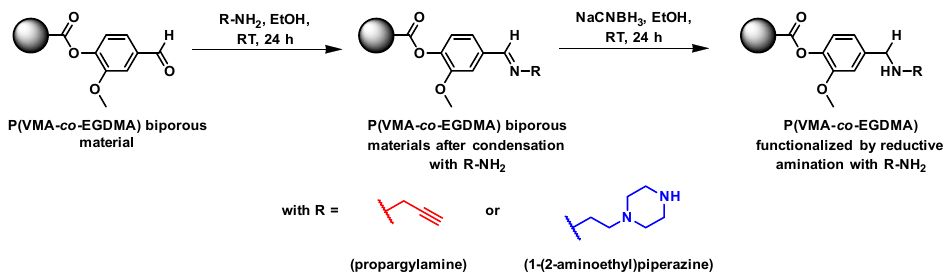
Figure 7. General scheme illustrating the pore surface functionalization of Poly(VMA -co- EGDMA) materials by reductive amination with 1-(2-aminoethyl)piperazine or propargylamine.